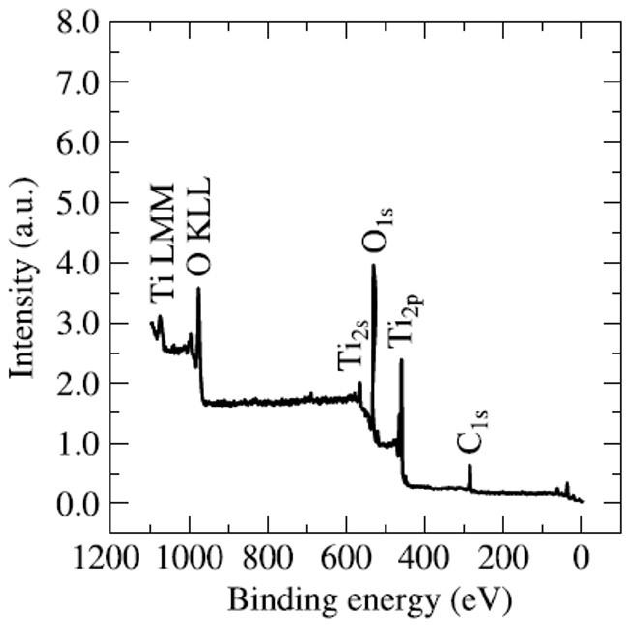
Figure 5. XPS survey spectrum of the sol–gel TiO 2 coating (TiO 2 /ns-Al).